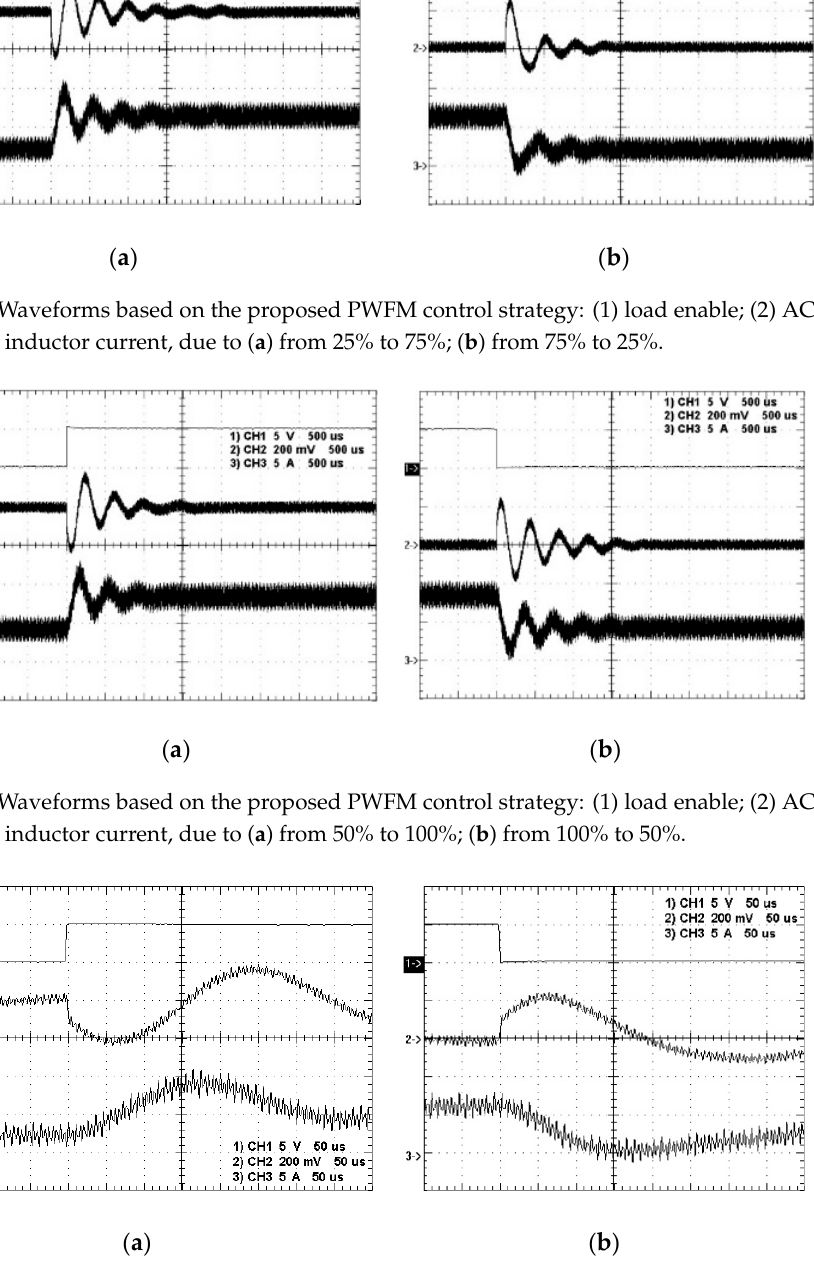
Figure 16. Zoom-in waveforms based on the traditional PWM control strategy: (1) load enable; (2) AC output voltage; (3) inductor current, due to ( a ) from 25% to 75%; ( b ) from 75% to 25%.